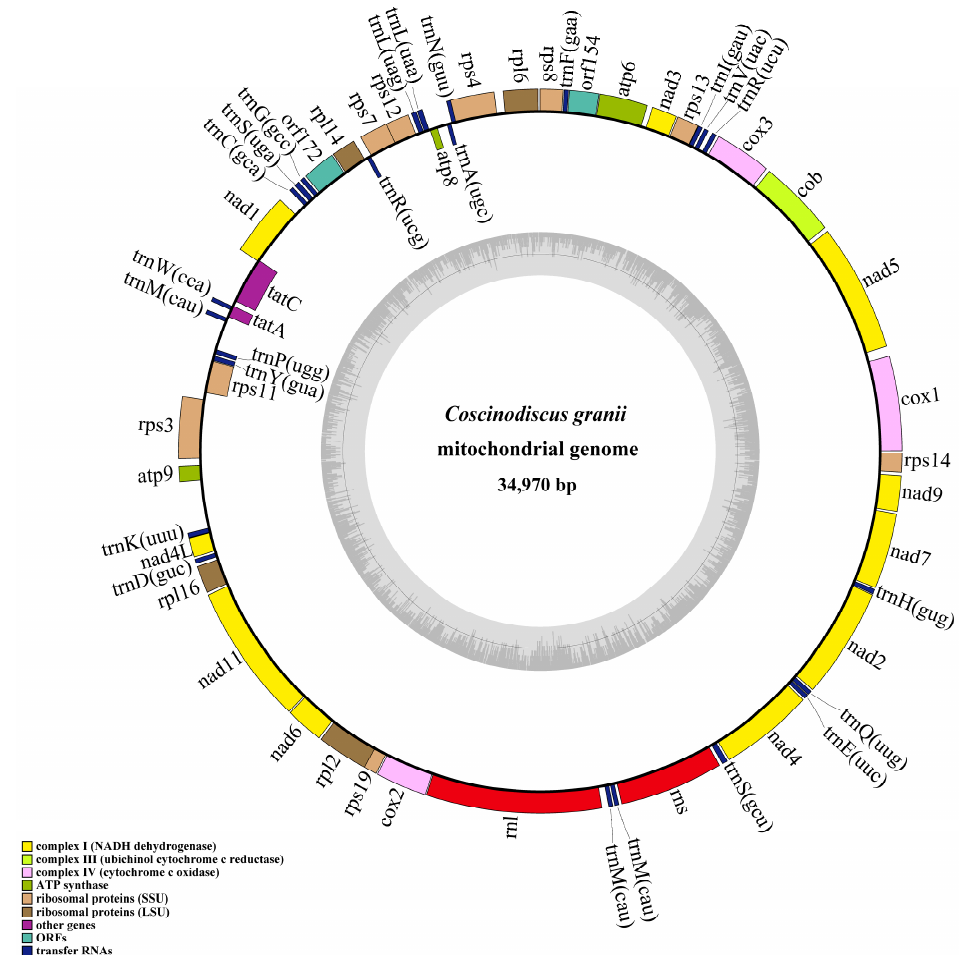
Figure 4. Circular maps of the mtDNA of Coscinodiscus granii (Strain CNS00554). Circular map of the mtDNA of C. granii . The transcriptional direction inside the ring is clockwise and the transcriptional direction outside the ring is counterclockwise. The protein-coding genes and rRNAs and tRNAs genes are labeled inside or outside the circle. The color of the gene boxes indicates the different functional groups of genes. The ring of bar graphs on the inner circle shows the GC content in dark gray.